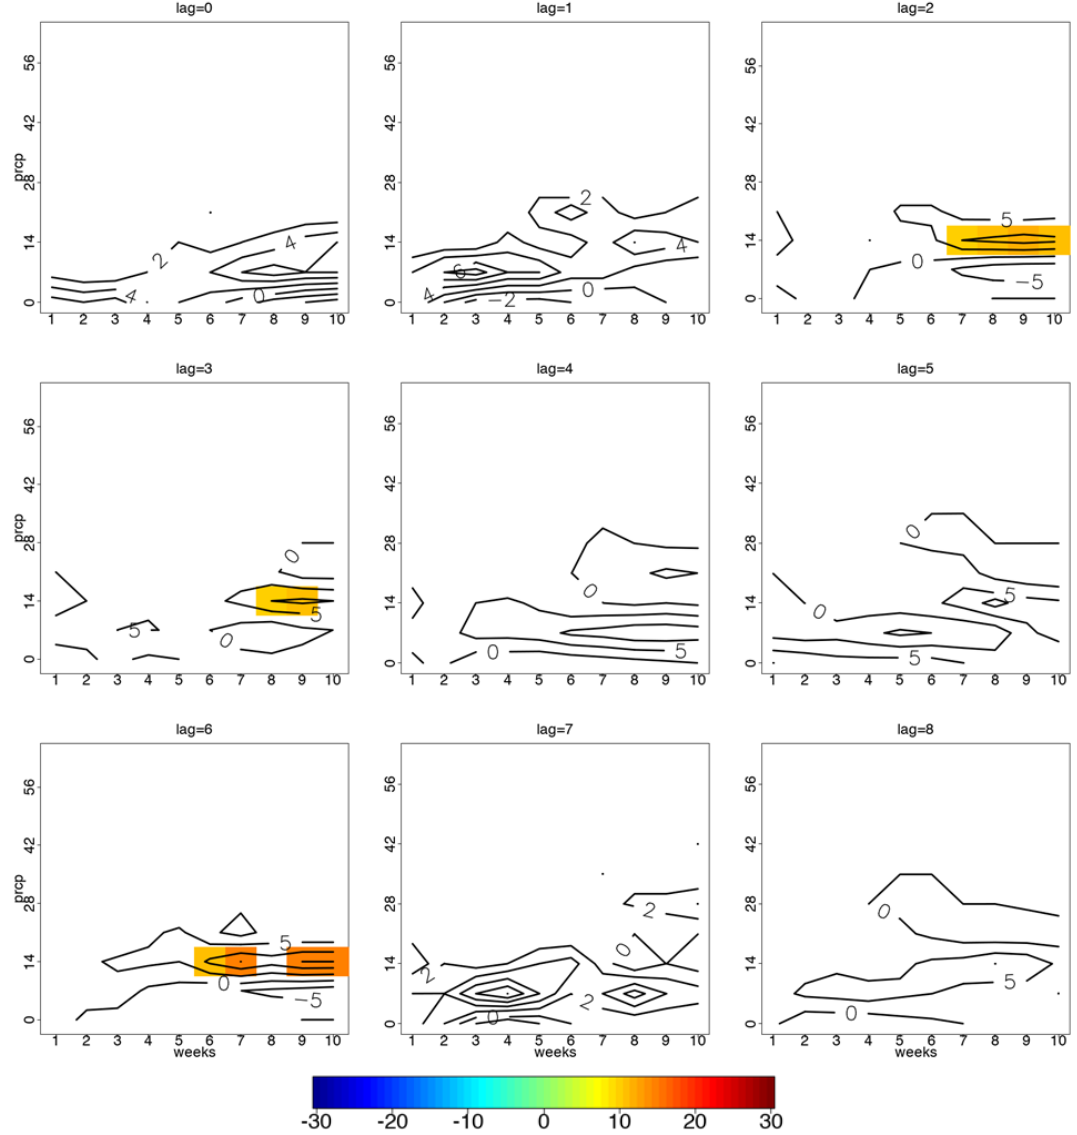
Figure 3. Statistically significant contour di ff erences in anomalously high and low diarrhoea case counts for lag 0 to 8 weeks per consecutive weeks of precipitation among individuals aged 5 years and older for season JJA. X-axis represents number of consecutive weeks in which the average precipitation reached over Y-axis representing rainfall in millimetres (mm). Warm colours represent higher frequency of (X, Y) occurring when diarrhoea case counts were anomalously higher than average.